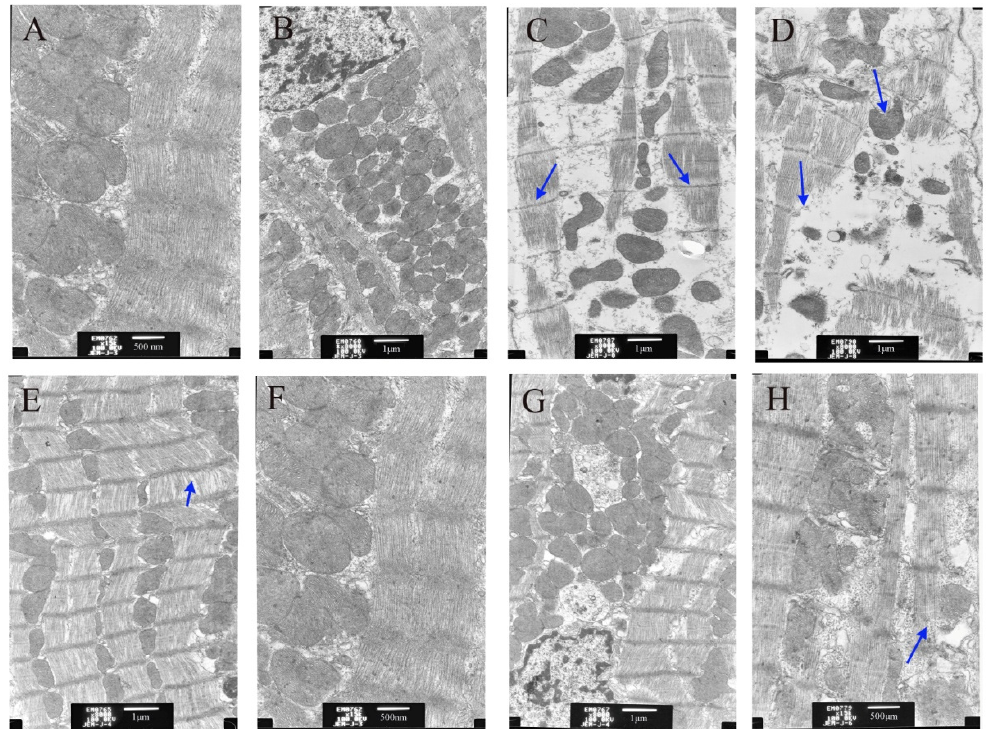
Figure 4. Ultrastructure of the rat heart tissue after different treatments under electron microscope. ( A , B ) Control; ( C , D ) CuSO 4 ; ( E , F ) GDL + CuSO 4 ; ( G , H ) Penicillamine + CuSO 4 . The arrows indicated